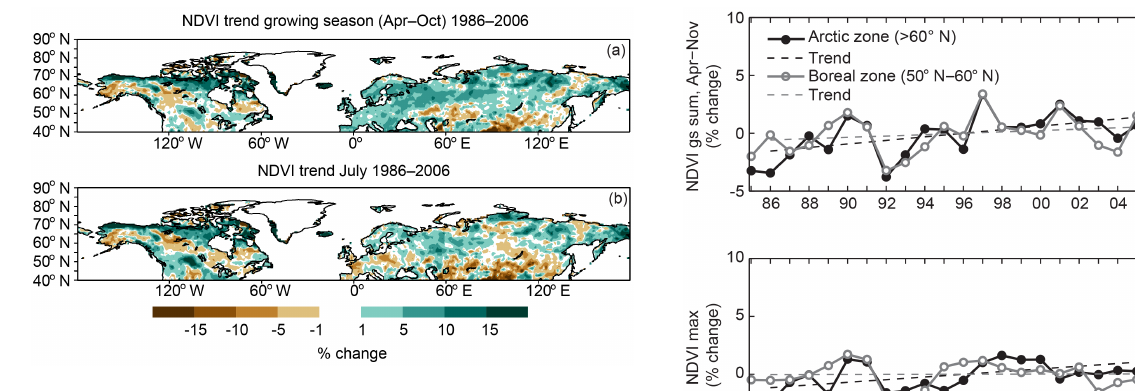
Figure 9. Gridded temporal trends in GIMMS 3g NDVI (a) growing season (April–October) mean and (b) July only from 1986–2006. Trends are expressed as percent changes from the mean.